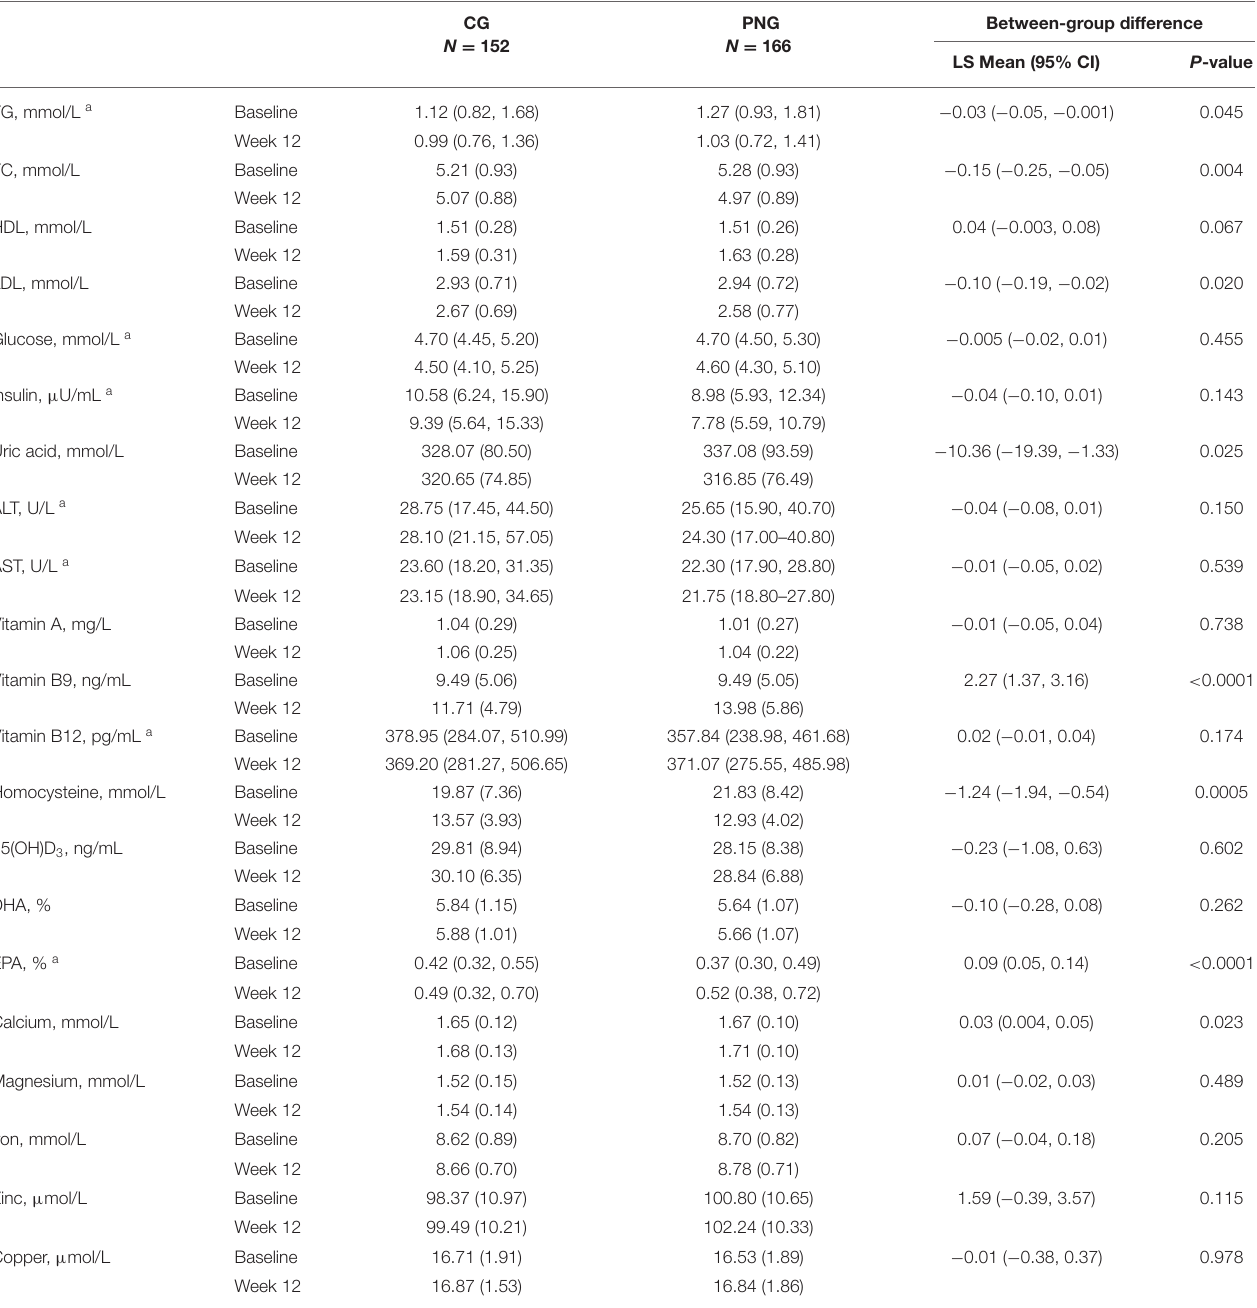
TABLE 2 | Blood biomarkers at baseline and at week 12 in both